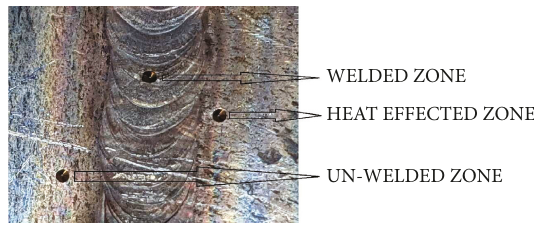
Figure 12: Zones of welded